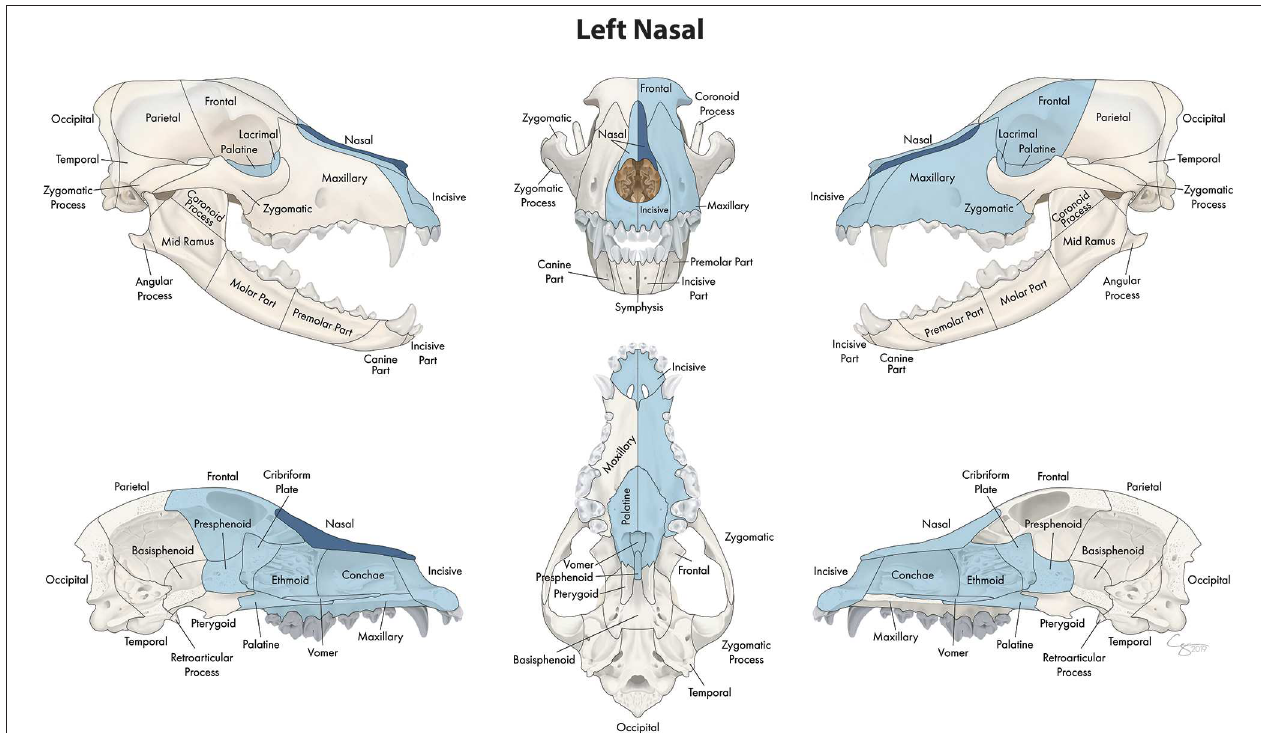
FIGURE 9 | Significant bones or regions fractured concurrently with the nasal bone. When the nasal bone was the region of interest, many other bones of the skull base/cranial vault and midface, both on the ipsilateral and contralateral side, fractured concurrently. Although the left nasal bone is shown, when the right nasal bone was the region of interest, a mirror image of concurrently fractured locations